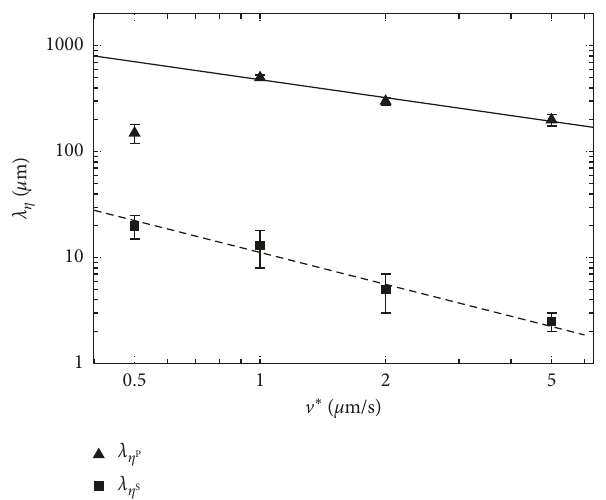
Figure 8: Fiber spacing λ